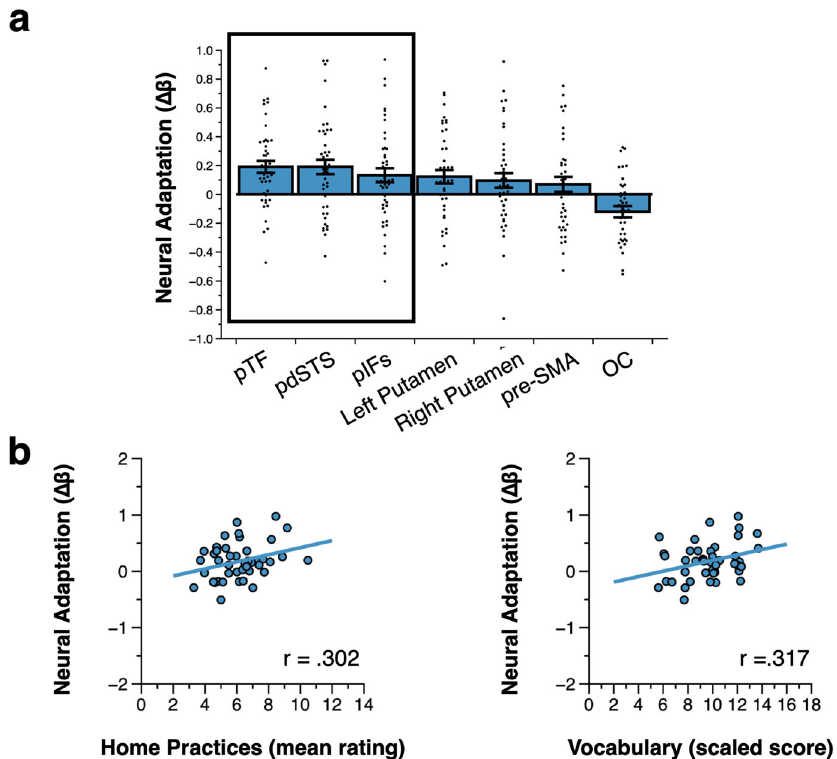
Fig. 5 Neural adaptation to words ( n = 44). a Average neural adaptation to words in the ROIs, ranked by effect size. The dark outline shows the brain regions for which word adaptation was signi fi cant after correction for multiple comparisons (excluding the left putamen, see text). Error bars represent the standard error of the mean (SEM). Each dot represents a participant. b Scatterplots of neural adaptation to words in the pIFs as a function of the overall frequency of home literacy practices (left) and child vocabulary (right). Analyses were controlled for parental income and